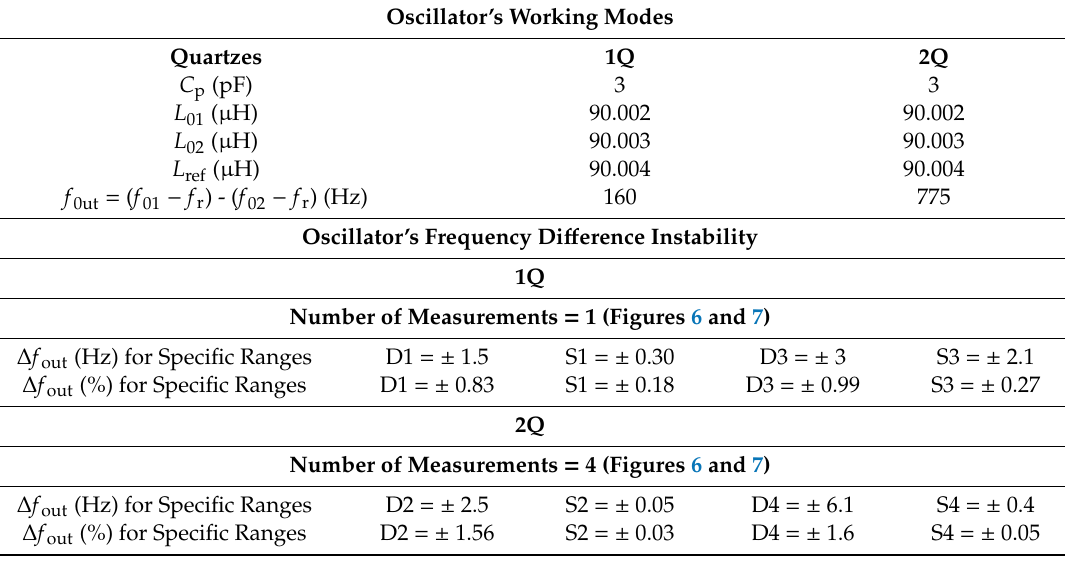
Table 2. Comparison of the frequency di ff erence f out for a single or two quartz crystals connected in parallel in the oscillator with the same C p and the same inductance L 01 , L 02 , and L ref